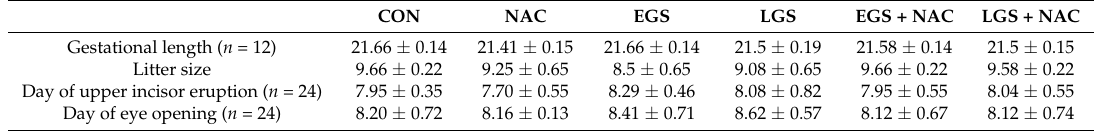
Table 1. Neonatal parameters following early and late gestational stress and prenatal NAC treatment. CON NAC EGS LGS EGS + NAC